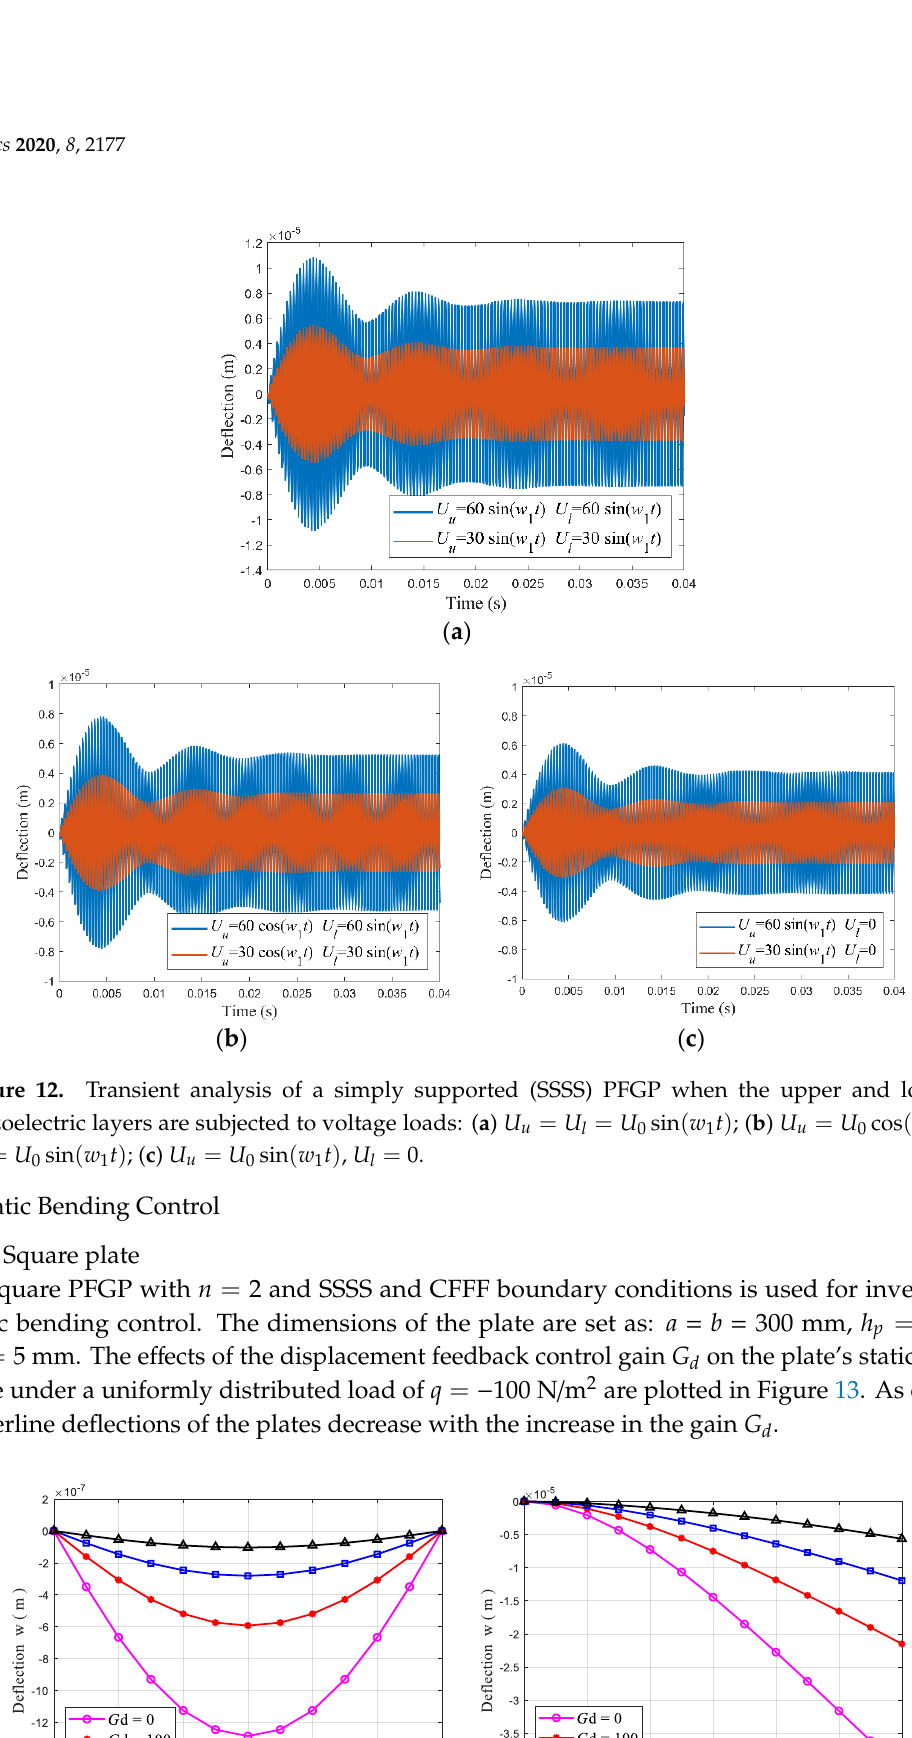
( d ) Figure 11. Dynamic analysis of a simply supported (SSSS) PFGP under four different sinusoidally distributed transverse forces: ( a ) Step load; ( b ) triangular load; ( c ) sinusoidal load; ( d ) explosive load.